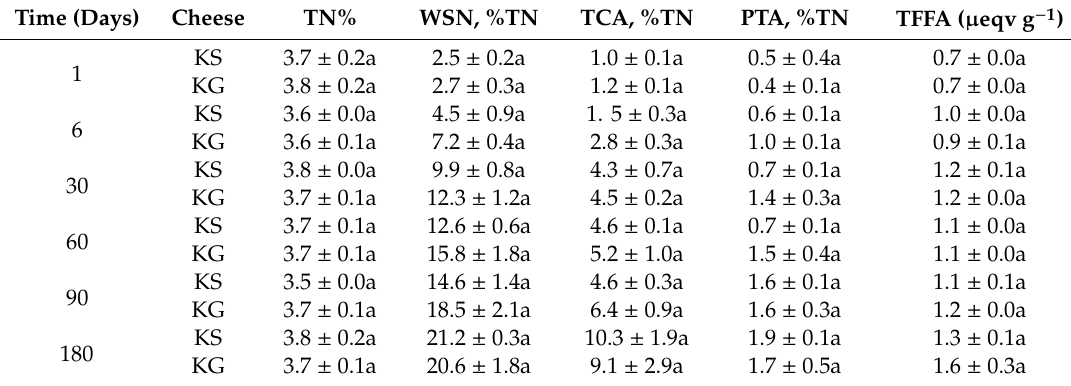
Table 6. Changes of total nitrogen, soluble nitrogenous fractions and total free fatty acid content